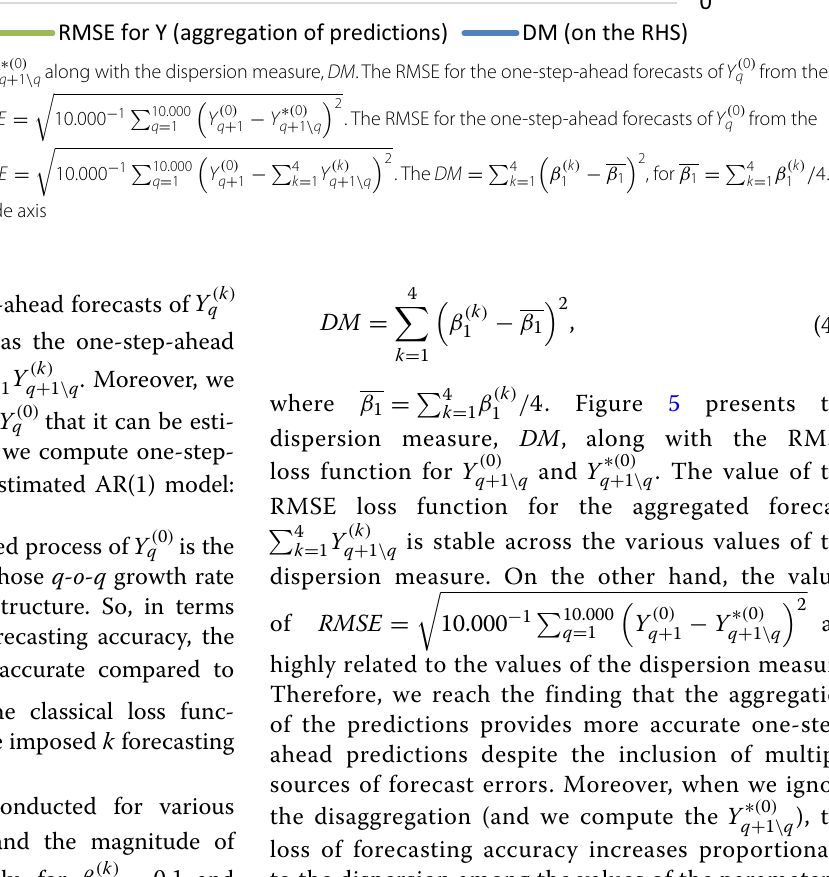
q from the 0 ) q from the